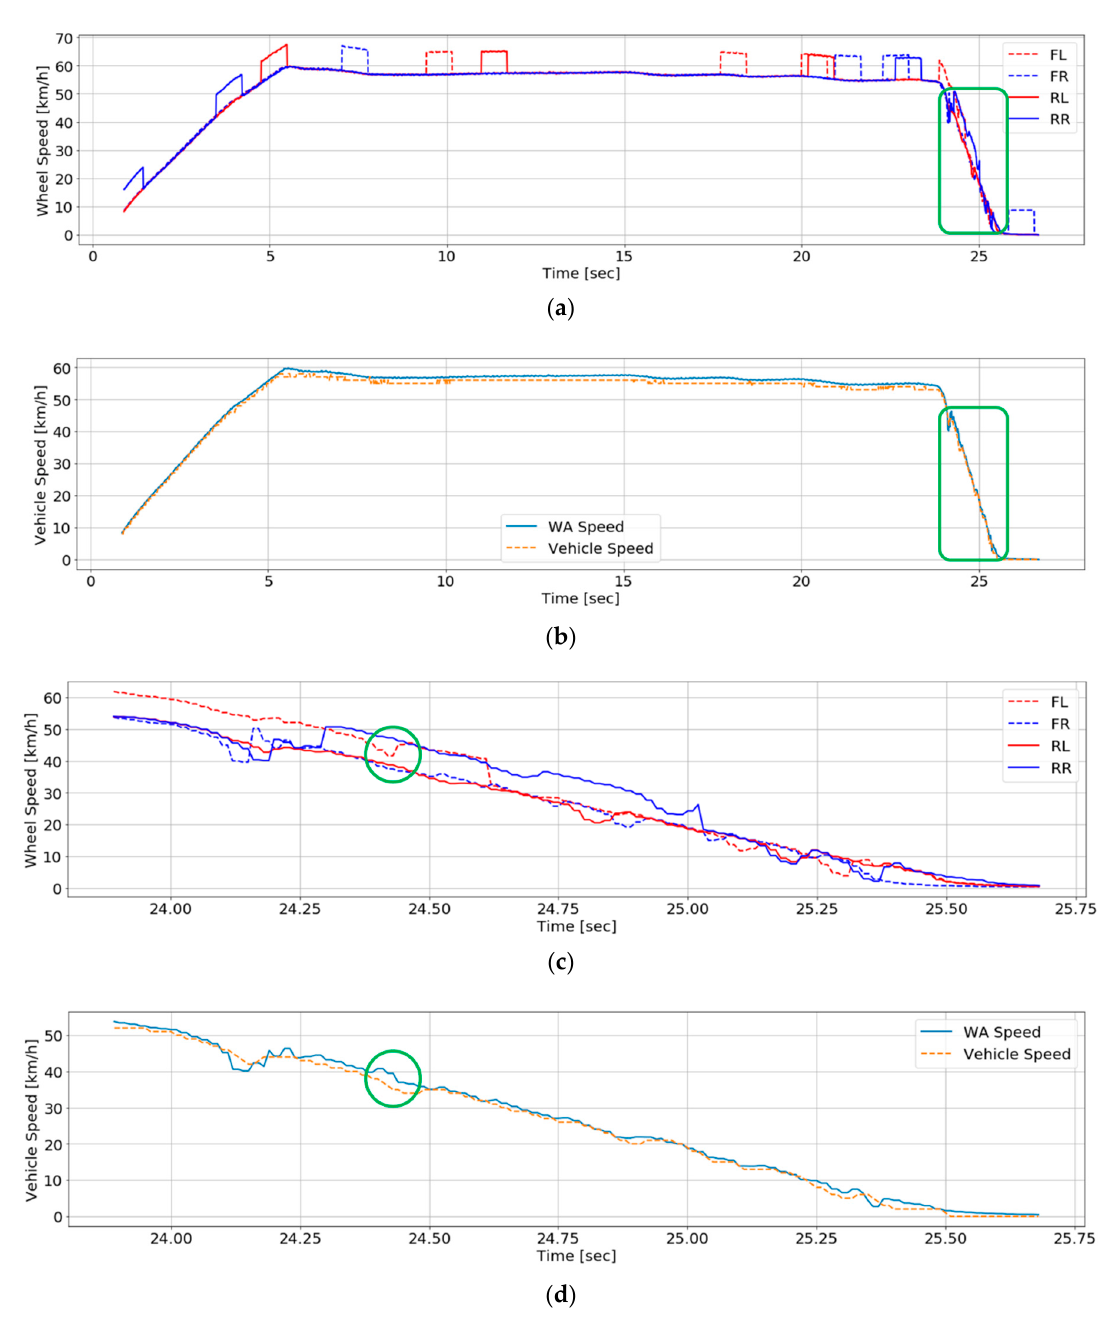
Figure 6. Another test dataset: ( a ) Test dataset before attack detection; ( b ) The estimated speed after attack detection and speed estimation and the reference speed; ( c ) A part of the test dataset before attack detection; ( d ) A part of the test dataset after attack detection and speed estimation.